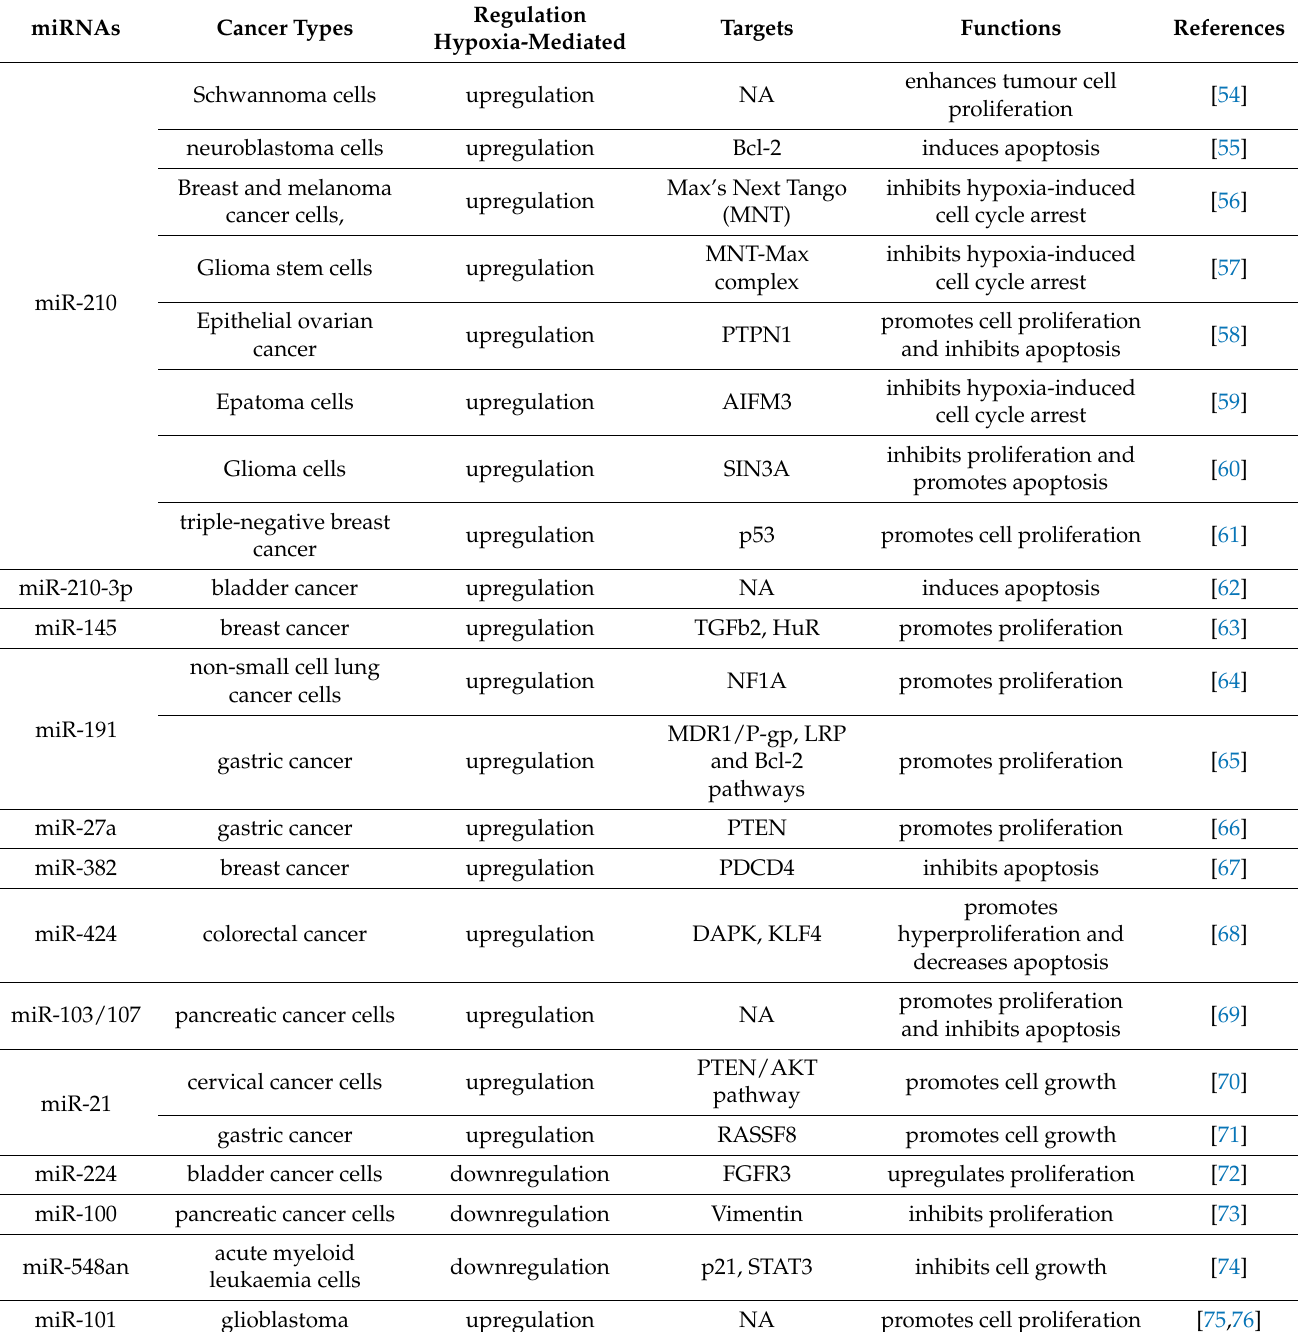
Table 1. List of hypoxia-responsive miRNAs involved in cell proliferation, apoptosis and cell cycle regulation.